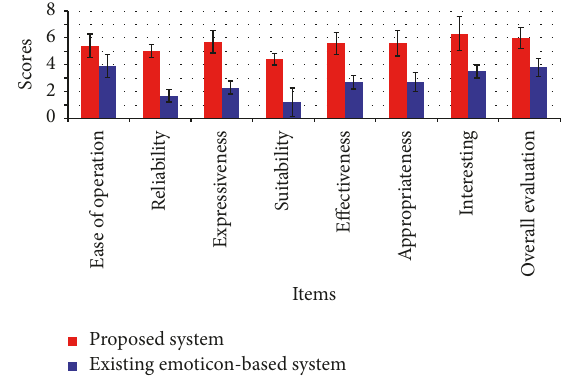
Figure 9: Results of questionnaire assessment based on the subjec- tive